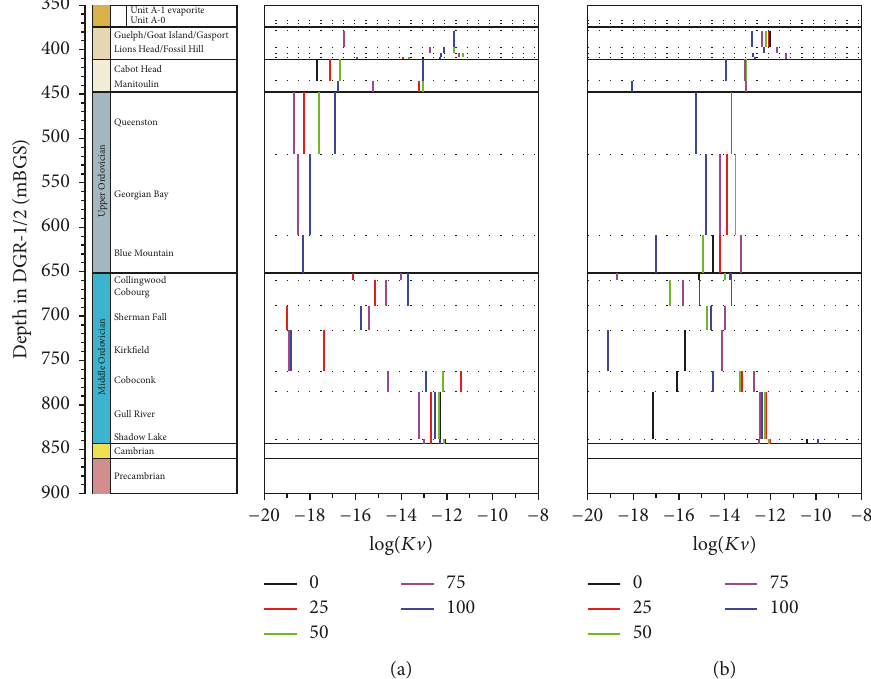
Figure 9: Calibrated vertical hydraulic conductivity using glaciation scenario nn9930. Coloured lines represent different percentages of ice-sheet thickness applied as excess head to the top boundary condition. Subfigure (a) uses present day environmental heads as the initial condition while subfigure (b) uses a hydrostatic head condition computed assuming